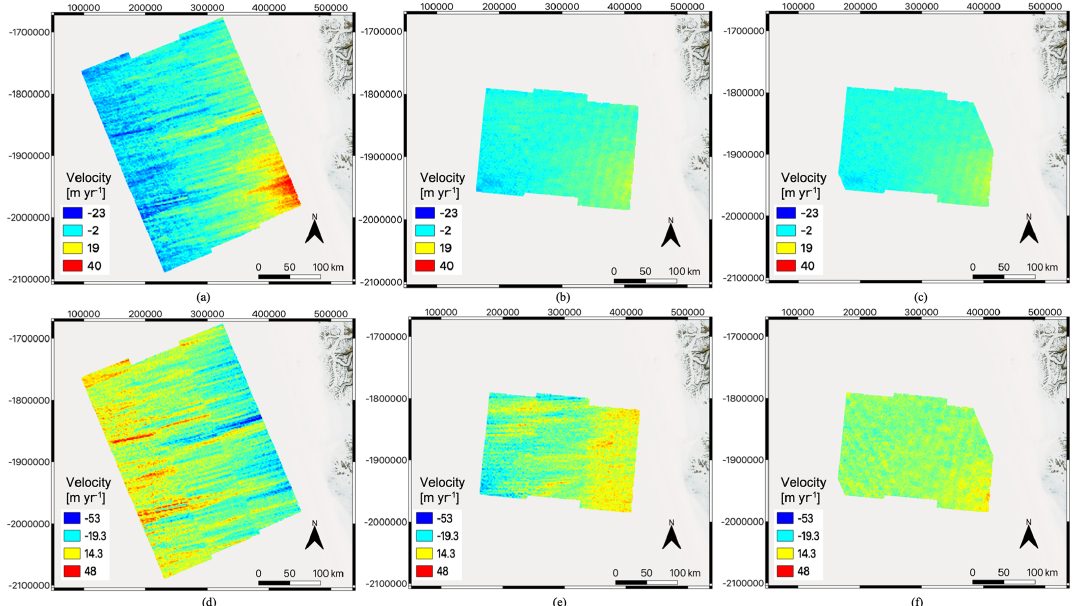
Figure 10. Ionosphere correction for ascending and descending acquisition geometry: (a) ascending x velocity, (b) descending x velocity, (c) ascending/descending combined x velocity, (d) ascending y velocity, (e) descending y velocity, (f) ascending/descending combined y ve- locity. The ascending/descending Sentinel-1 image pairs were both acquired on 20171226–20180101 in Region 3. Background: © Microsoft Bing Maps